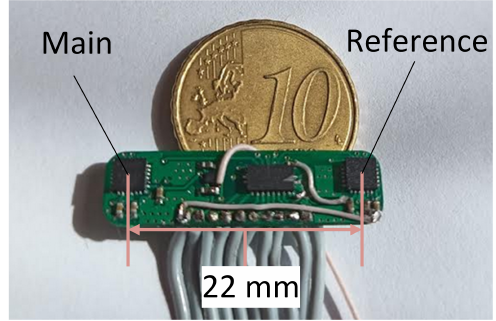
Figure 4. Prototype sensor